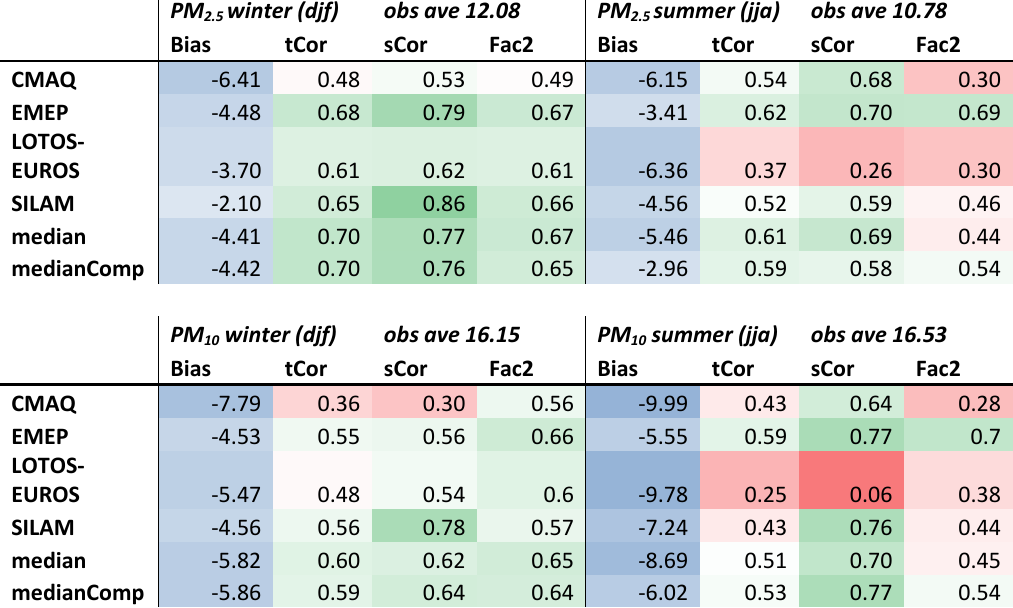
Figure 3. Observed and predicted seasonal concentrations of PM 2 . 5 (left) and PM 10 (right), mean over the EMEP stations (µgPMm − 3 ). The light blue part shows the aerosol-bound water amount at the filter weighting conditions (50% relative humidity, 20 ◦ C), estimated with ISORROPIA2 based on the modelled aerosol composition. The solid light blue shows the water content in stable case (the lower curve of the hysteresis loop) and the striped part in metastable case (the upper branch of the hysteresis loop), when the crystallization has not occurred to aerosol coming from more humid conditions. Table 5. Model-measurement statistics for dry PM for the four models and the two ensemble median models. The colour scale emphasizes the range of